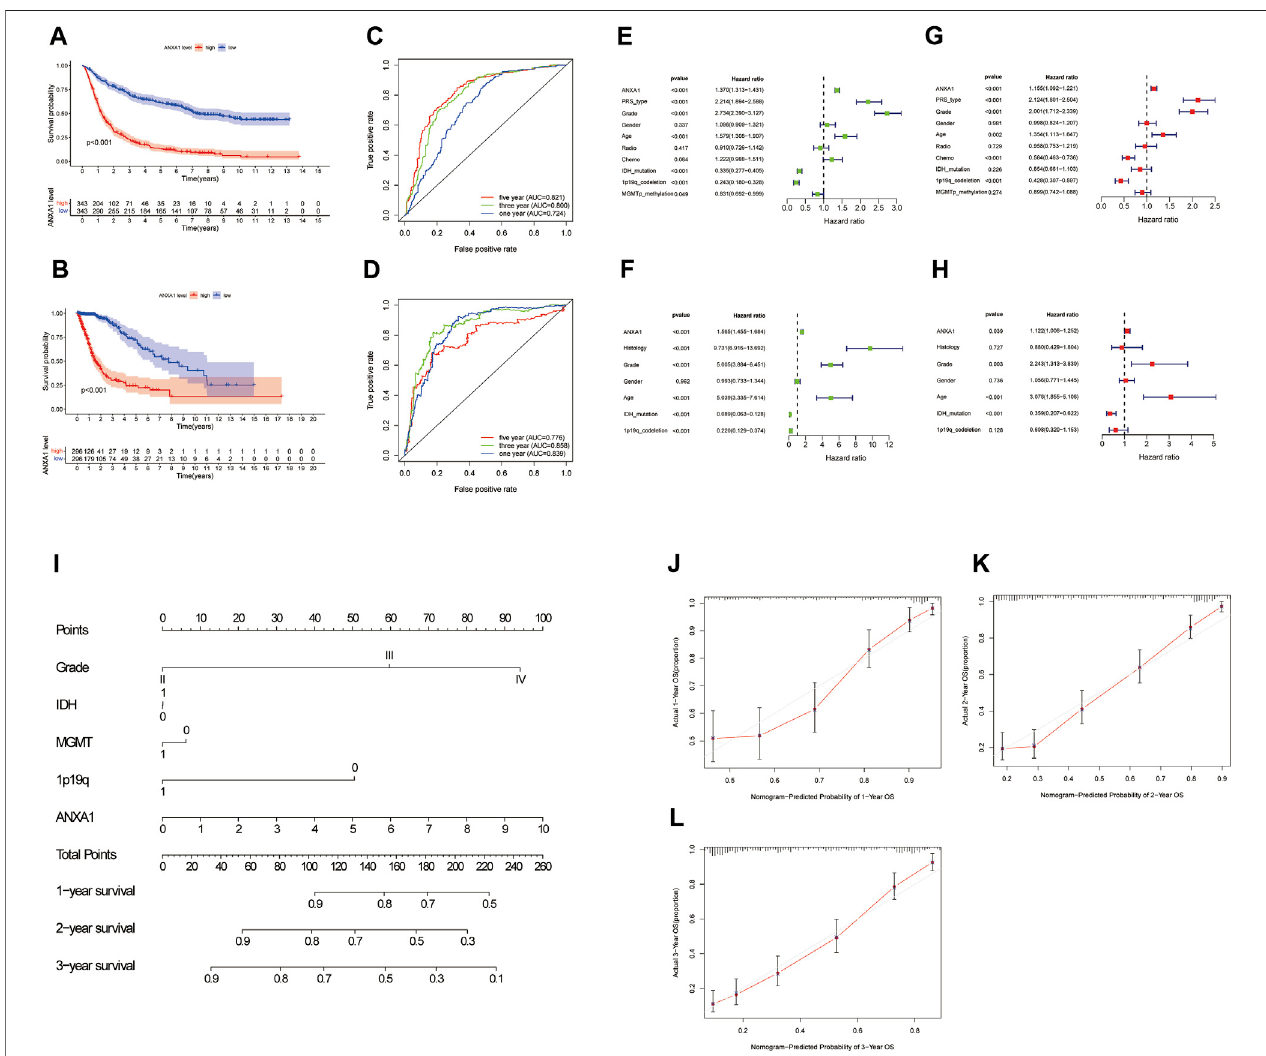
FIGURE 3 | Survival analysis and independent prognostic analysis of the ANXA1 gene in glioma. (A,B) Survival analysis of ANXA1. (C,D) Survival ROC curve of ANXA1 at 1, 3, and 5 years. (E,F) Univariate analysis of ANXA1. (G,H) Multivariate analysis of ANXA1. (I) Based on the clinical information of the CGGA database, a prognostic nomogram model was constructed. (J – L) Calibration curve was constructed according to the CGGA database information. The scores of ANXA1, grade, IDH, MGMT, and 1p19q factors were used to predict the calibration curve of the 1-year, 2-year, and 3-year prognostic nomogram.